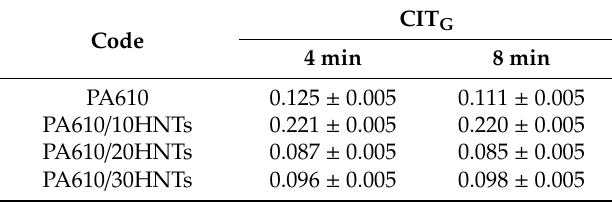
Table 7. Summary of the results of the conventional index of toxicity (CIT G )